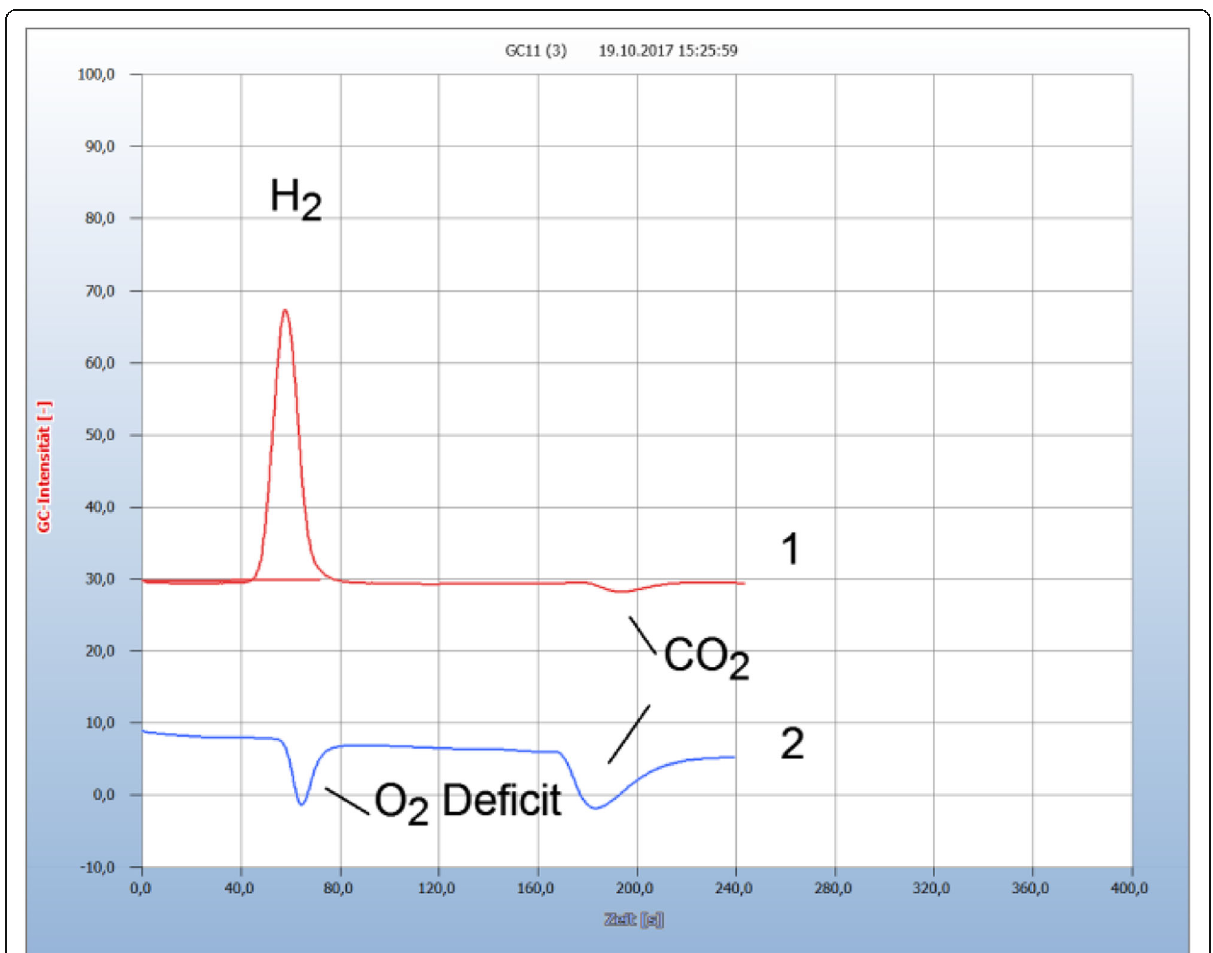
Fig. 2 Facultative anaerobic (1) and obligate aerobic (2) bacteria in salad samples. 1, packaged chopped salad; 2, unpackaged bio-salad. GC- column 1: silica